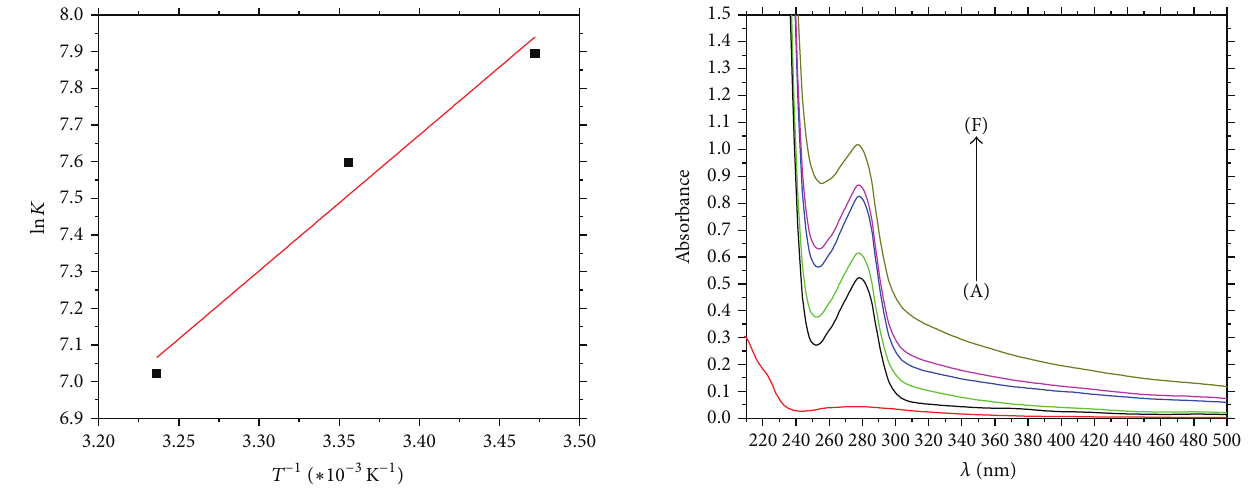
Figure 6: Absorbance spectra of EVG 10 𝜇 g mL −1 (A), BSA 0.8 mg mL −1 (B), and EVG-BSA system at EVG concentration of (C)